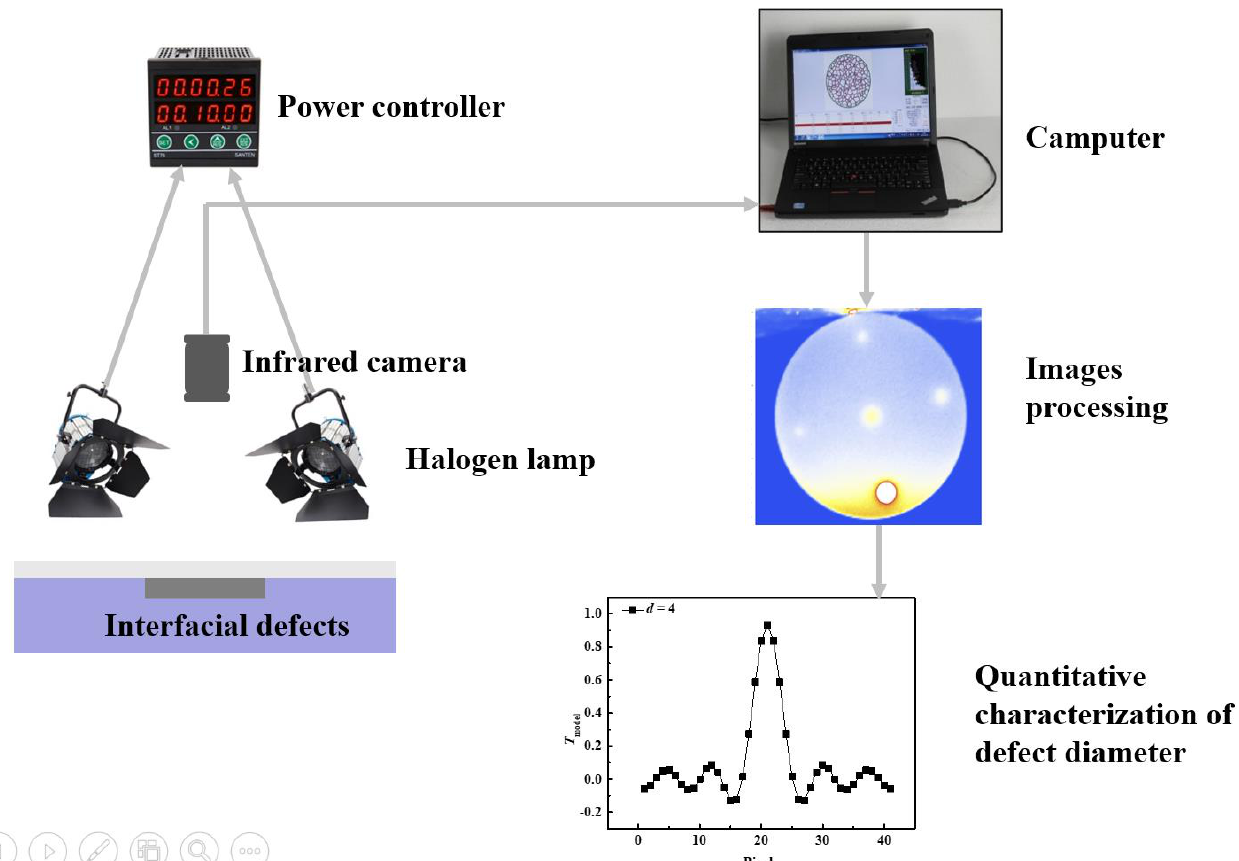
Figure 2. A flow diagram of defect detection by LPT.